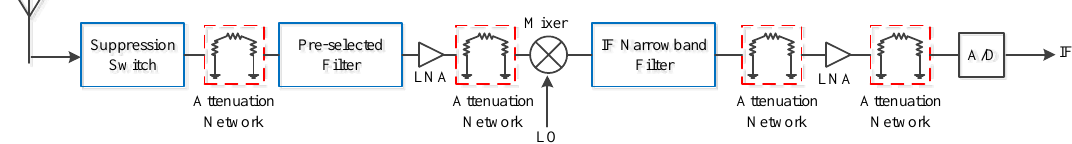
Figure 6. The circuit design of the analog channel. Between the levels, several “π” networks are employed to match the impedance and adjust the gain consistency of each channel.